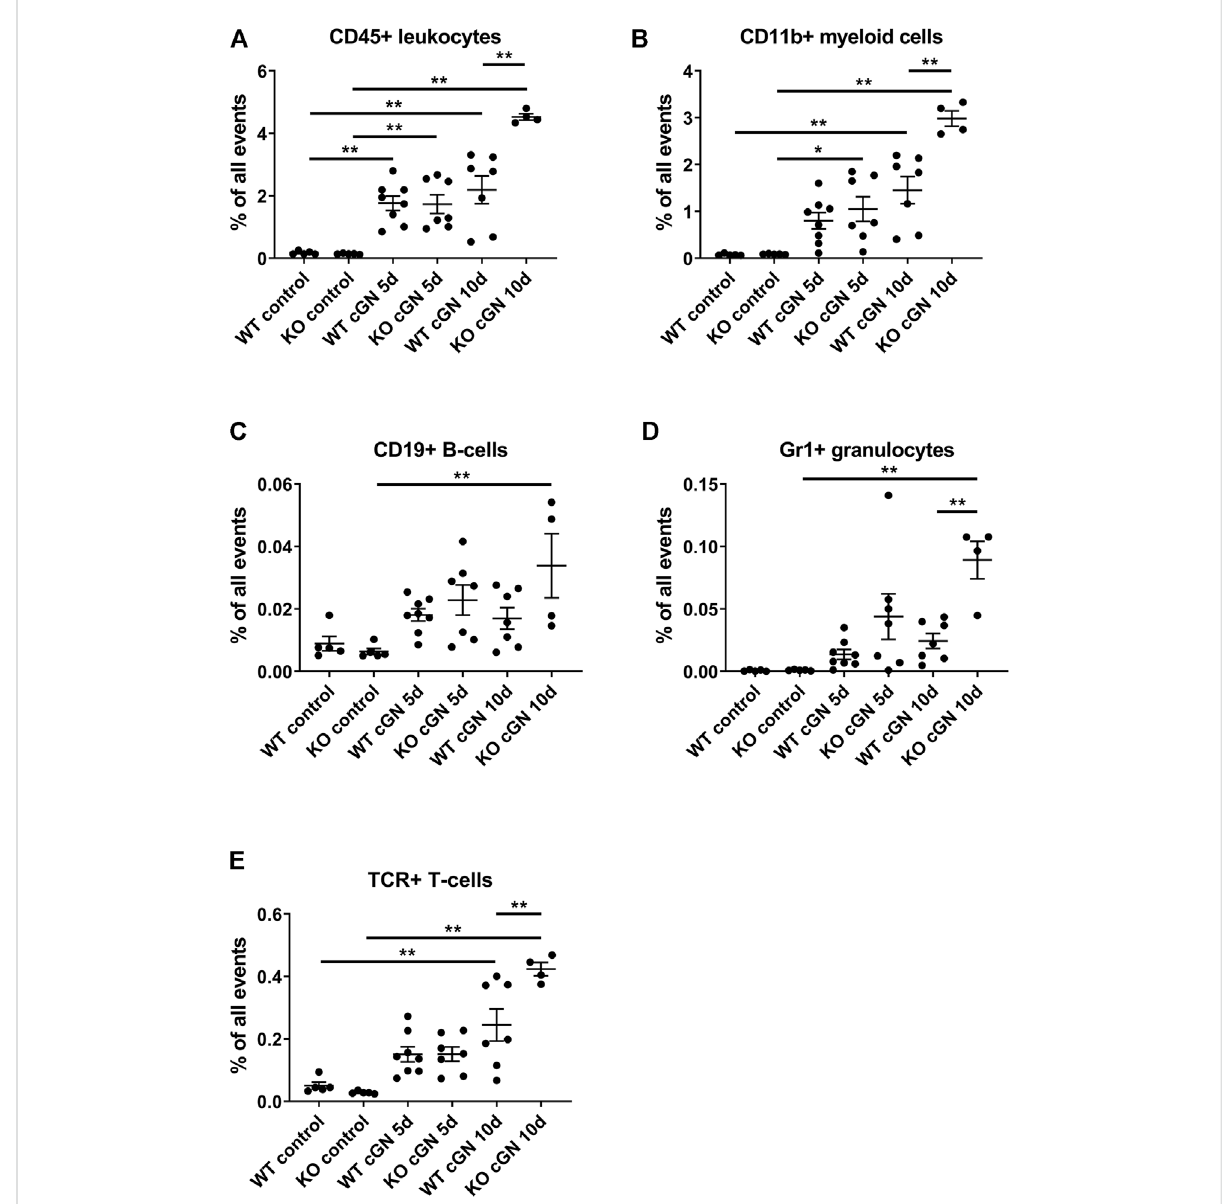
FIGURE 4 De fi ciency of annexin A1 aggravates renal in fl ammation Flow cytometry quanti fi cation of renal CD45 + leukocytes (A) , CD11b + myeloid cells (B) , CD19 + B-lymphocytes (C), neutrophilsde fi nedasliveCD45 + /GR1 HIGH cells (D) andT-lymphocytesde fi nedasliveCD45+/ β -TCR + cells (E) inwildtype (WT) and annexin A1 (AnxA1)-de fi cient mice (KO) at d5 and d10 after injection of normal sheep serum (control) or induction of crescentic glomerulonephritis (cGN). Dots represent values from individual animals; horizontal lines indicate mean values and error bars represent the SEM. Statistical signi fi cance of changes was calculated using one-way ANOVA; * p < 0.05; ** p < 0.01; n = 5 – 8 per